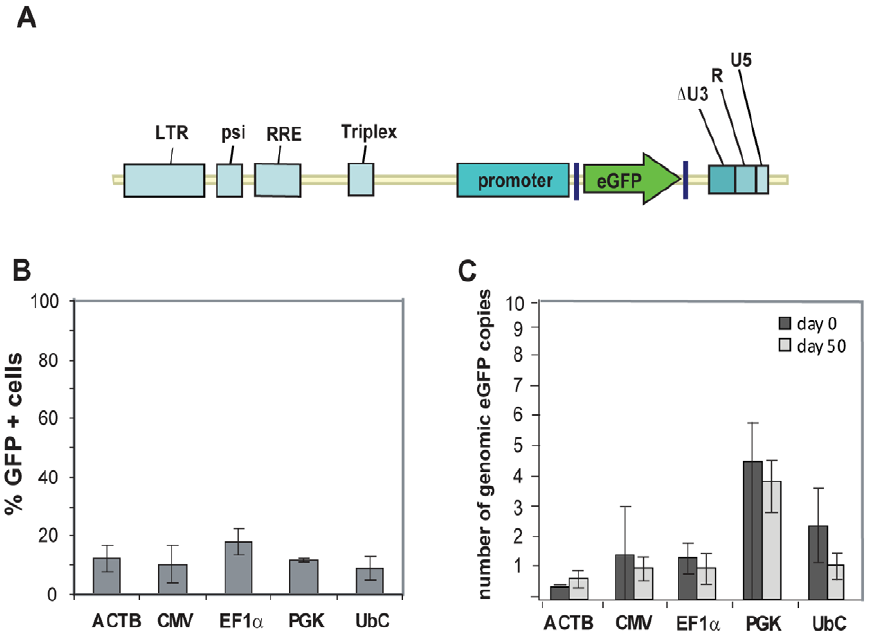
Figure 1. Transduction efficiency in hESCs SA121. A . Schematic representation of pTRIP lentiviral vectors, in which eGFP are under the control of ACTB-, CMV-, EF1 a -, PGK- or UbC promoters. The hESC line SA121 was transduced with lentiviral vectors; pTRIP-ACTB-, CMV-, EF1 a -, PGK-or UbC- eGFP. Ten days after transduction, cell populations were analyzed by FACS to determine the percentage of cells that expressed GFP. B . Percentage of transduced hESCs expressing eGFP. C . Determination of number of transgenic inserts in the GFP positive cells by qPCR at time of FACS isolation (day 0) and after 50 days of culture. Data in A and B are shown as mean of three independent experiments. Error bars represent standard deviation of the mean ( 6 s.d.).